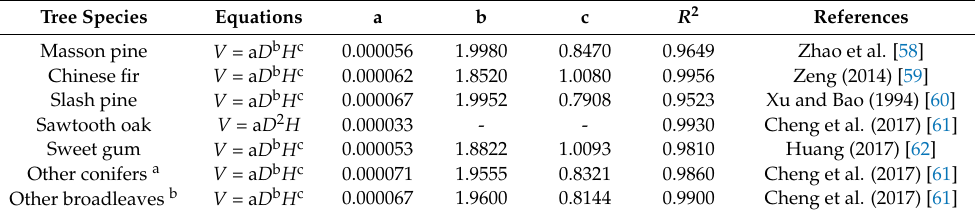
Table A1. Tree volume equations of dominant conifer and broadleaf species in the site. Tree